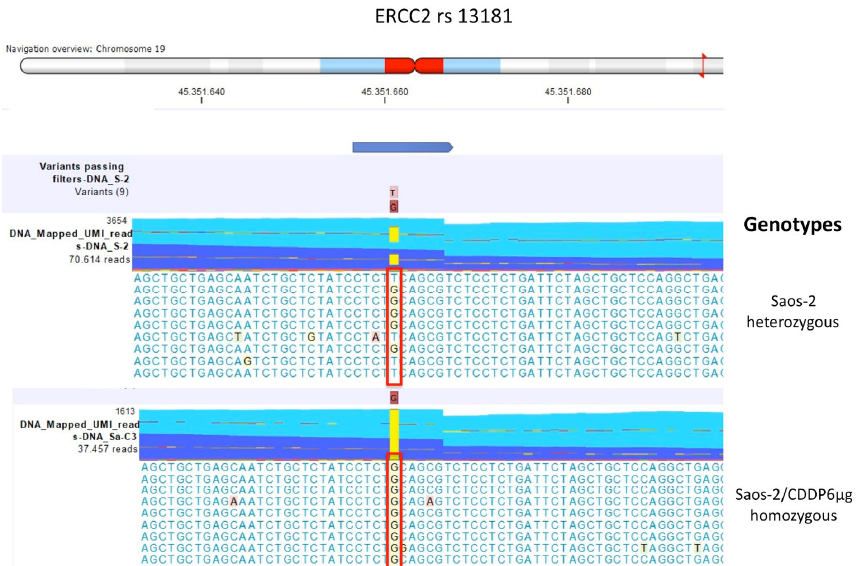
Figure 4. ERCC2 rs13181 genotypes identified by multimodal targeted next generation sequencing (mmNGS) in Saos ‐ 2 cell line and Saos ‐ 2/CDDP6 μ g variant. Mismatched nucleotides are evidenced by the CLC Genomics Workbench (GWB) with a background color according to the Rasmol color scheme. The red square box indicates the polymorphism alleles.